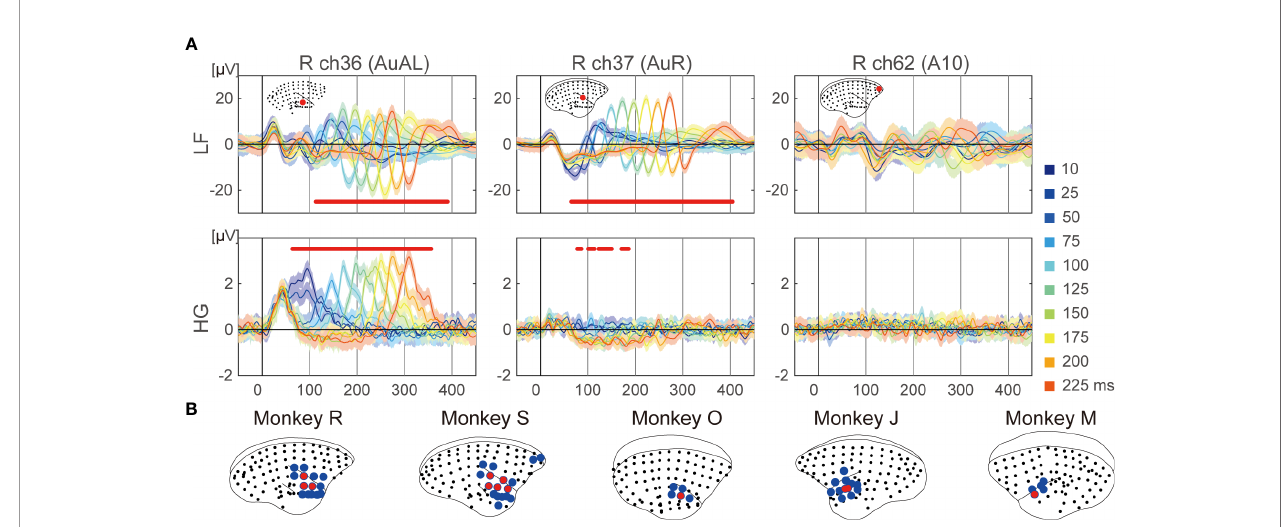
FIGURE 3 | Tone offset responses. (A) Examples of representative ECoG responses to each duration on selective electrodes of monkey R. Mean responses to each 10 duration are represented. The shaded areas correspond to the 95% con fi dence intervals. The red dots represent the time points which showed signi fi cantly different responses to durations. (B) Cortical maps of the tonotopy of LF (blue) and HG